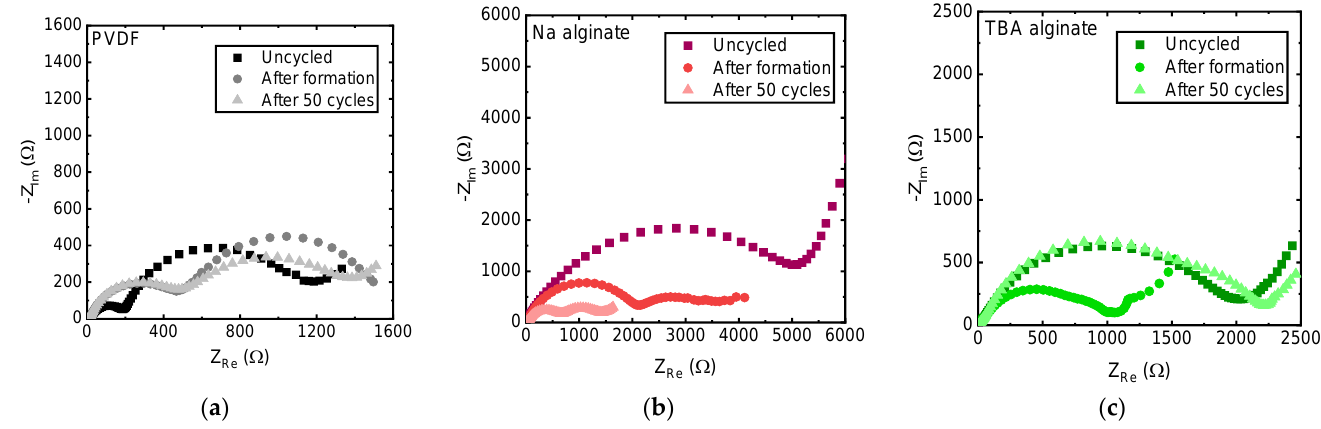
Figure 6. EIS spectra of Na 0.67 MnO 2 electrodes prepared with ( a ) PVDF, ( b ) Na alginate and ( c ) TBA alginate binders, measured 3 h after assembly of the cell, after 3 formation cycles at a slow rate and after 50 cycles at 1 C (175 mA/g).